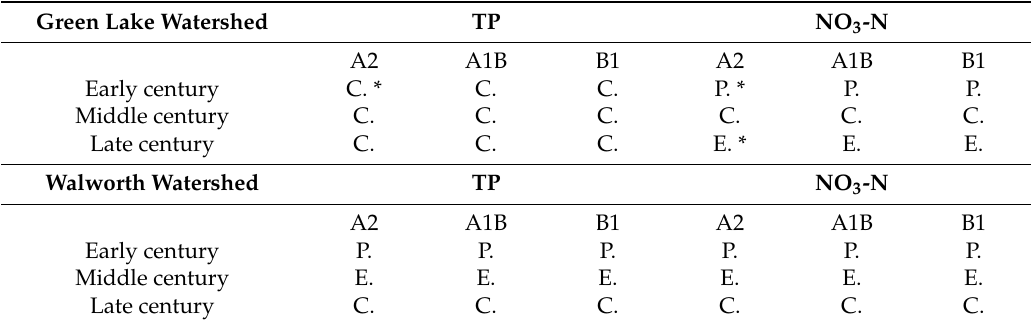
Table 8. The major influencing factors of NO 3 -N and total phosphorus (TP) losses.